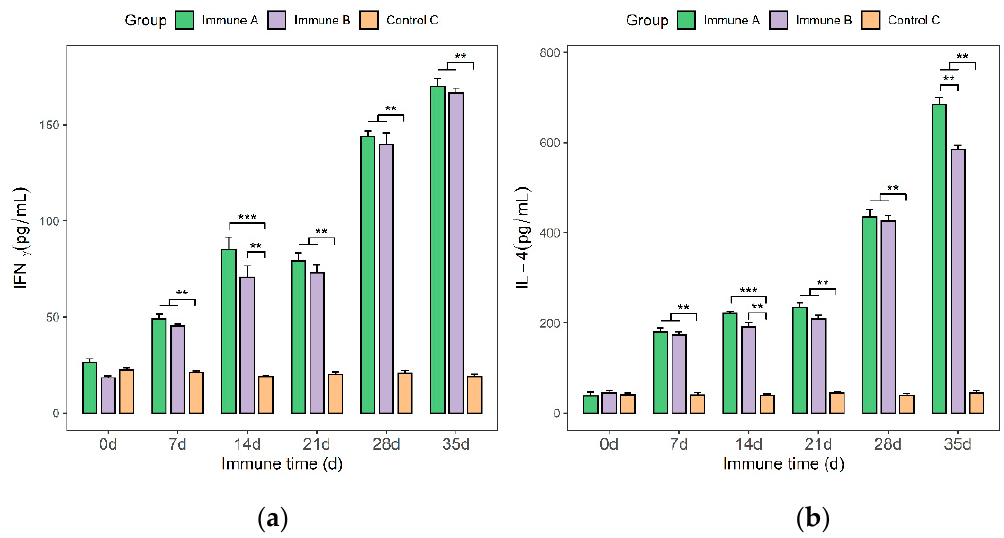
Figure 8. Serum IFN- γ and IL-4 levels in piglets from various immunization groups. ( a ) After the first immunization, the level of IFN- γ in group A was highly significantly different from that of group C ( p < 0.01 or p < 0.001). ( b ) After the initial vaccination, the level of IL-4 in group A was highly significantly different than that of group C ( p < 0.01 or p < 0.001). ** p < 0.01 shows a highly significant difference, and *** p < 0.001 shows an extremely significant difference.